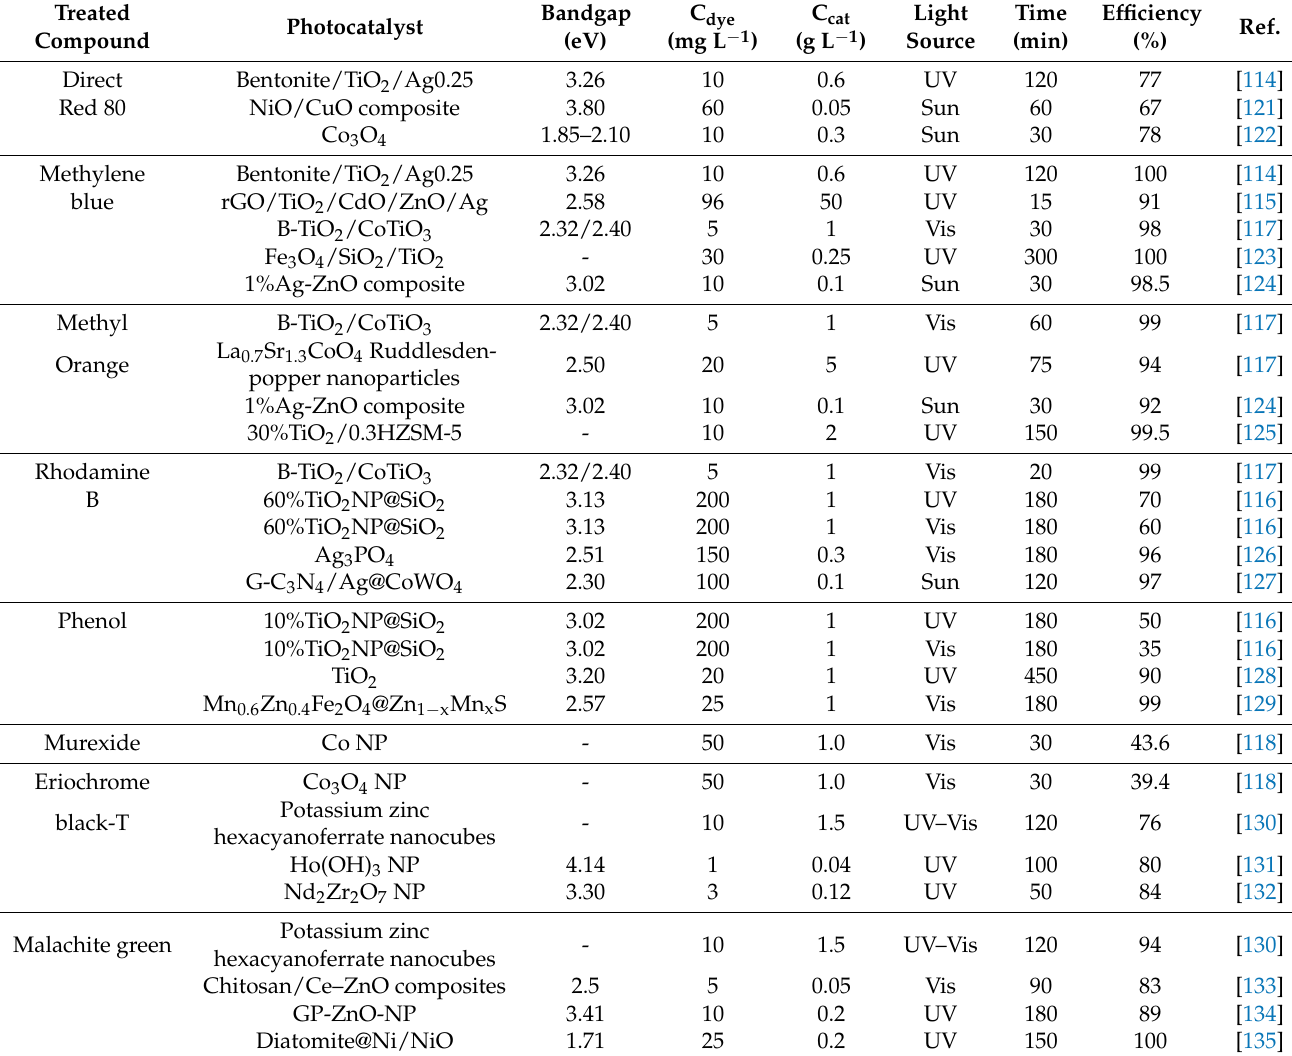
Table 2. Comparison of different nano-photocatalysts for degradation of different